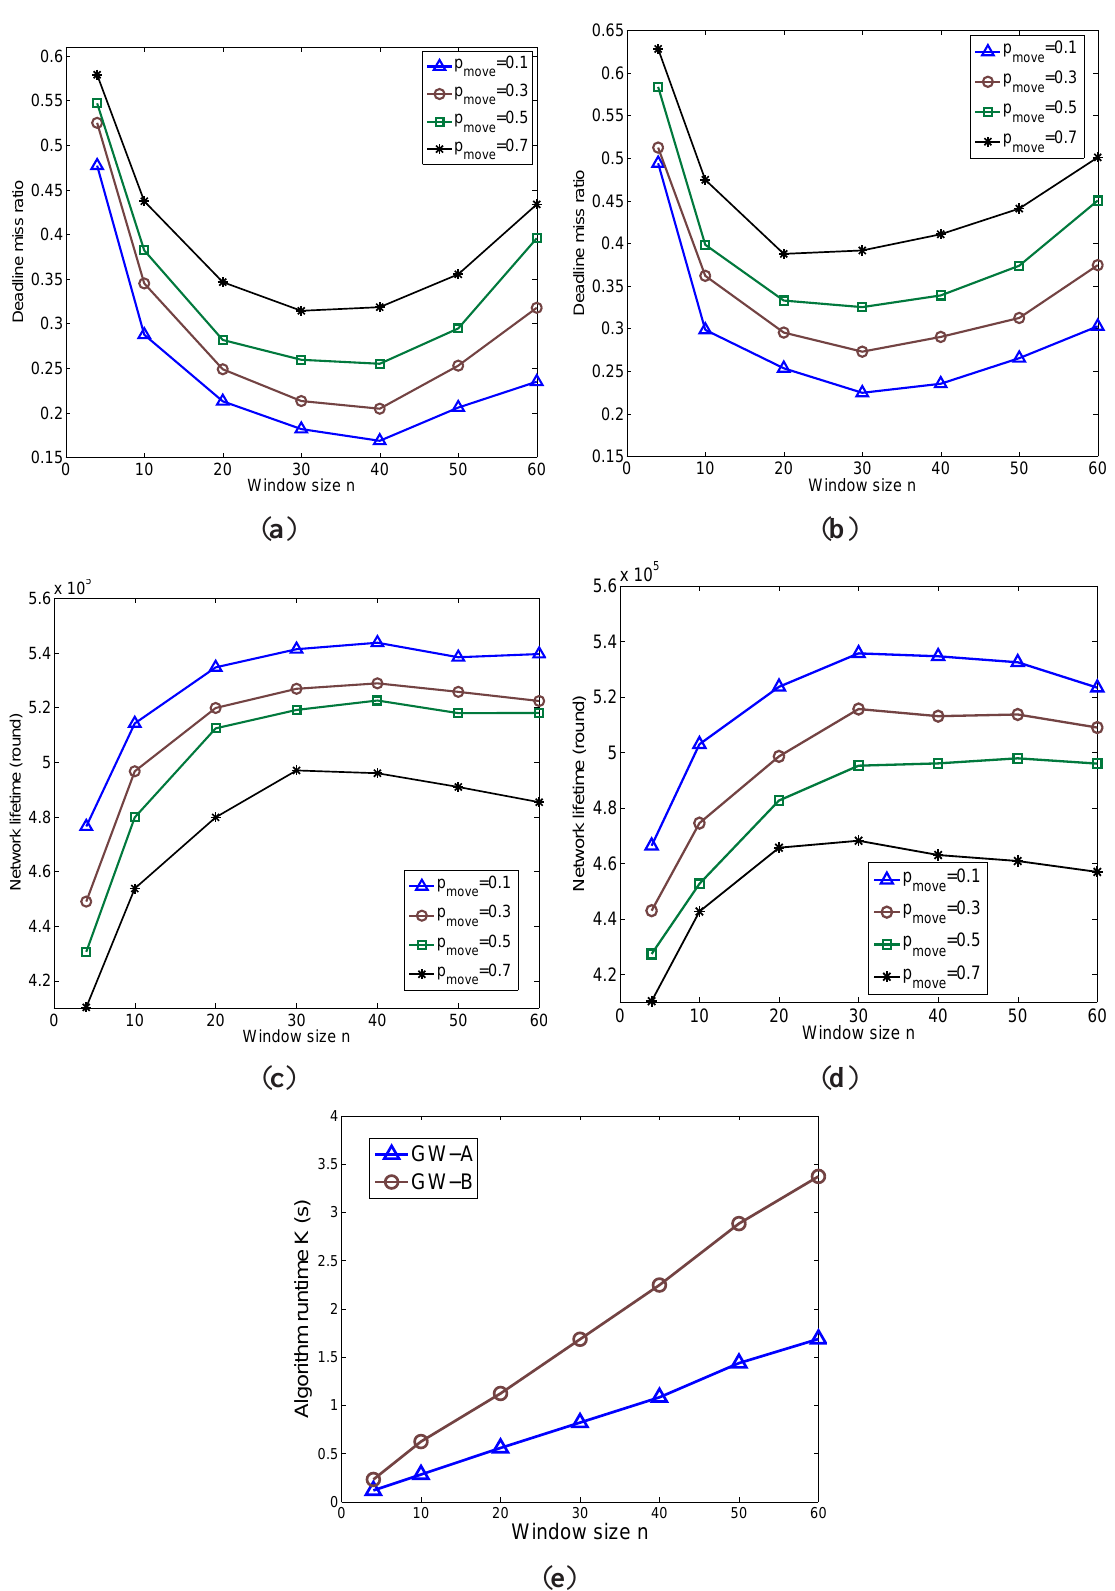
( ν = 1 m/s ). ( a ) Deadline miss ratio (GW-A); ( b move move